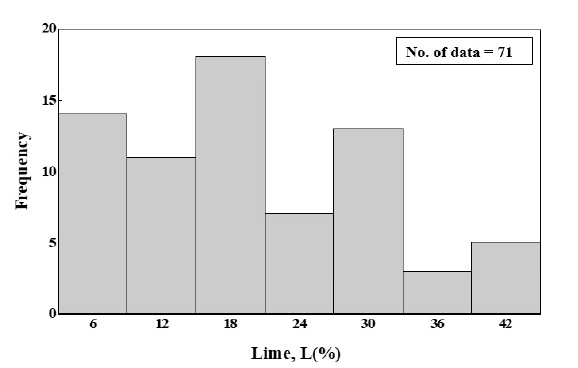
Figure 4: Histogram of the water to cement ratio (w/c) for (a) ce- ment mortar and (b) cement mortar modified with lime used in the literature